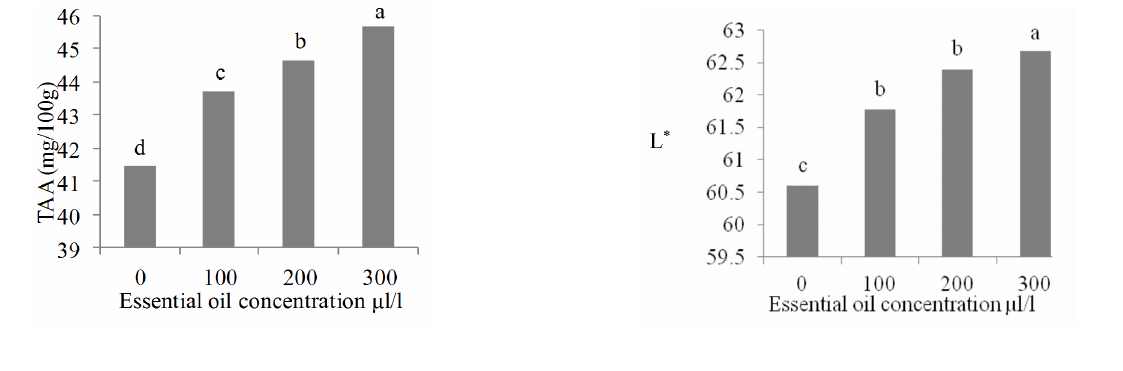
Fig. 8. The effect of basil essential oil treatment on L * of ‘Golden Drop’ plum